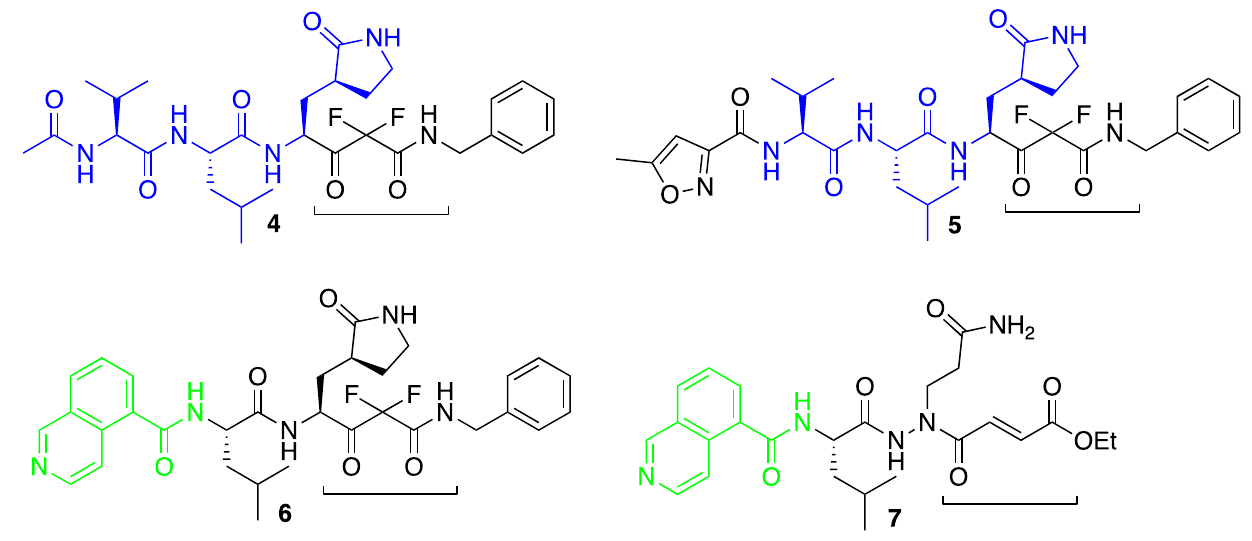
Figure 2. Chemical structures of potential inhibitors of SARS-CoV-2 M pro ( 4 – 7 ) reported in this study.